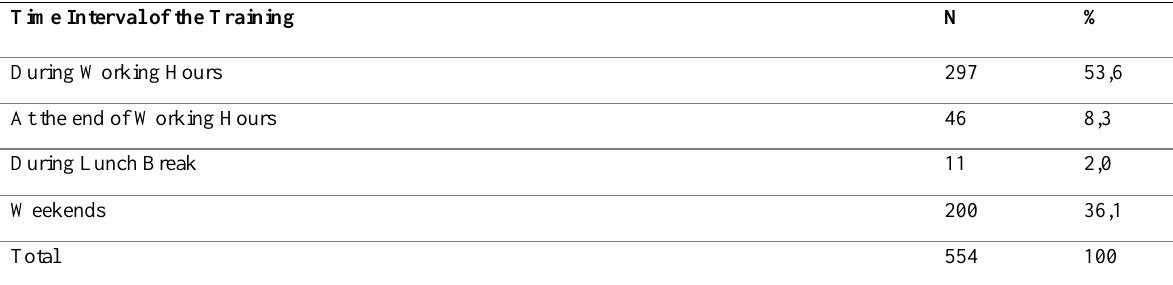
Table 18: Time Interval for In-Service